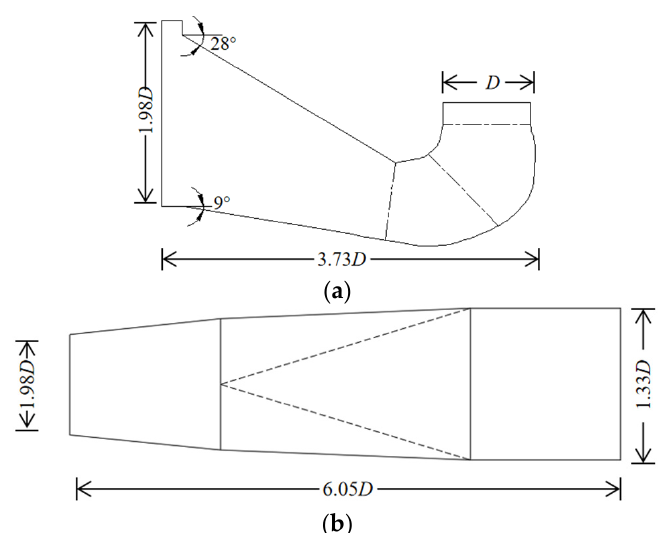
Figure 2. Three dimensional model of the vertical axial-flow pump device.